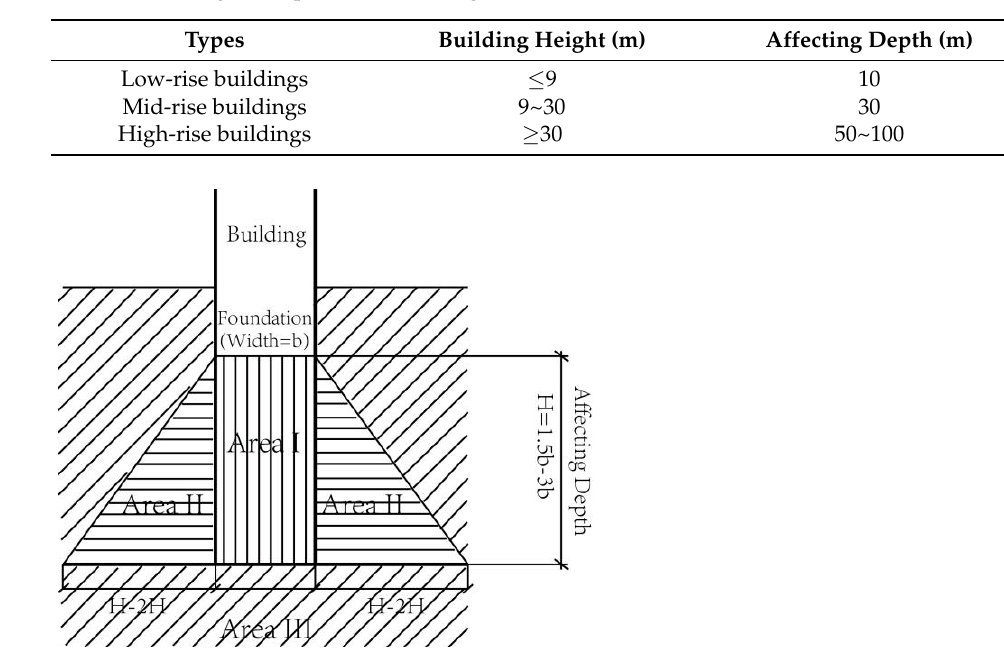
Figure 9. Process of capacity evaluation of USR. Table 6. Affecting the depth of the building foundation.